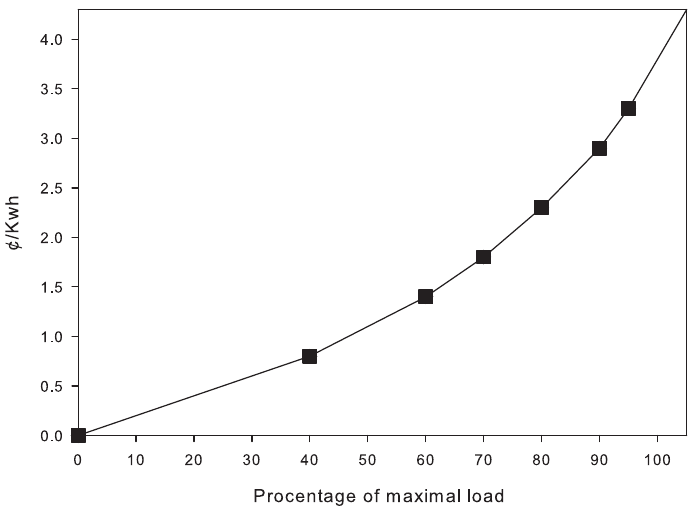
Figure 5. A piecewise linear convex cost function f ( ˆ l ) of instantaneous power consumption with seven consumption classes. Cross-over points are used to distinguish the